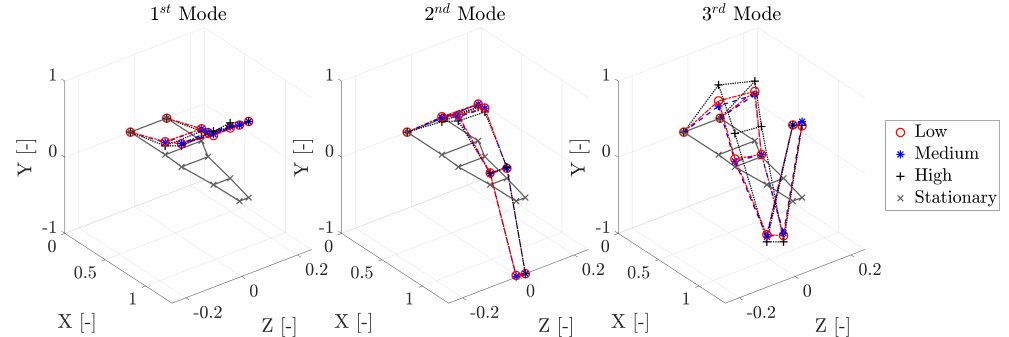
Figure 14. Main spar: mode shapes of the first three vertically dominant modes.